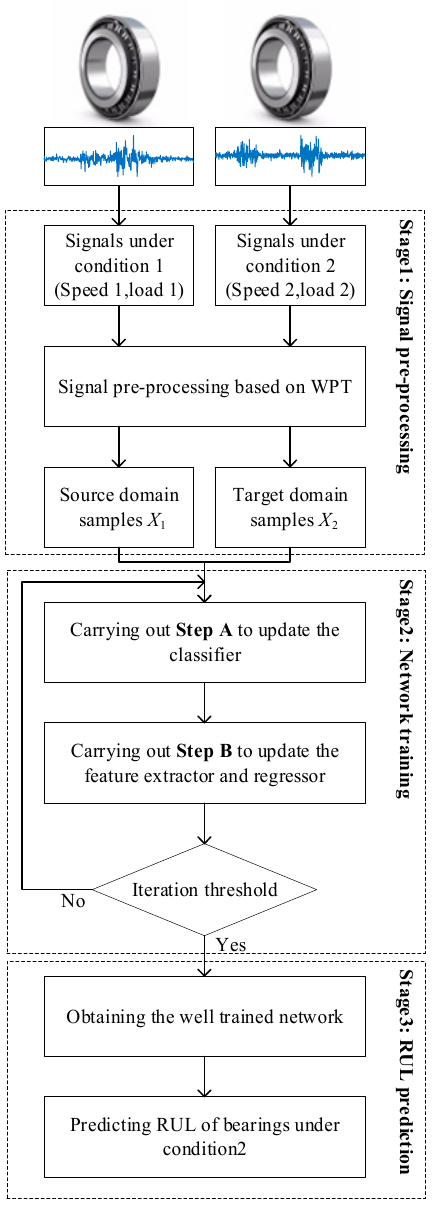
Figure 3. Flowchart of the proposed method for RUL prediction.